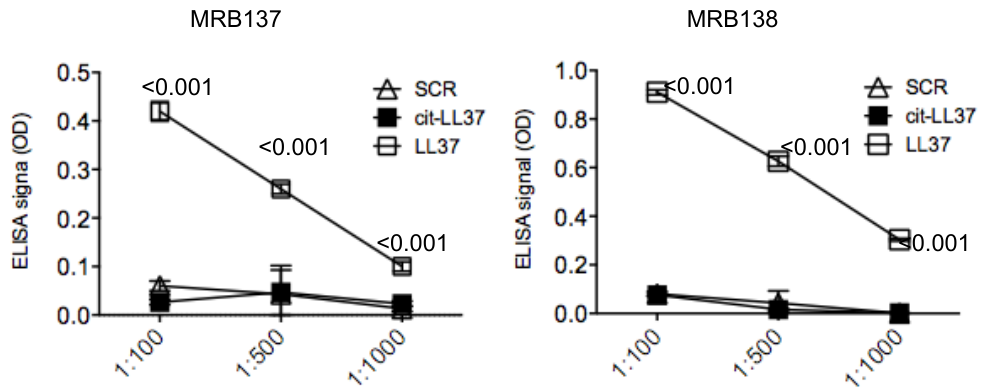
Figure 1. MRB137 and MRB138 recognize specifically native LL37. MRB137 and MRB138 (as specified